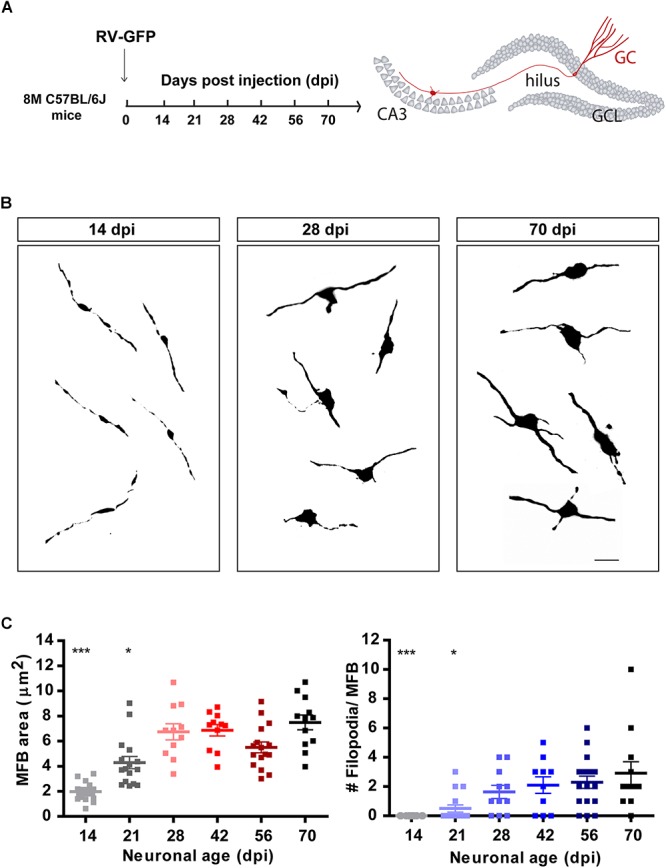
Development of mossy fiber boutons (MFBs) in new GCs. (A) Experimental design. RV-GFP was infused in the right dentate gyrus of 8 M mice. Morphology of MFBs in CA3 was analyzed at different times after confocal imaging. (B) Representative images of MFBs in CA3 at the indicated times. Scale bar, 5 μm. (C) MFB area and number of filopodia. (∗) and (∗∗∗) denote p < 0.05 and p < 0.001 compared to 70 dpi GCs after Kruskal–Wallis test followed by Dunn’s test. Sample sizes (neurons/mice): 14/3 (14 dpi), 16/3 (21 dpi), 11/2 (28 dpi), 11/2 (42 dpi), 16/3 (56 dpi), and 12/2 (70 dpi). Horizontal bars denote mean ± SEM.